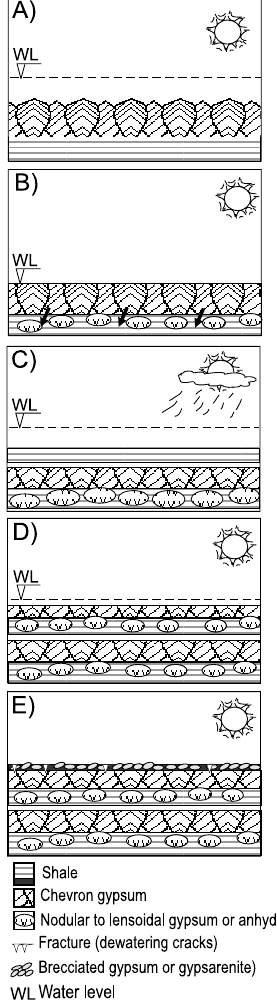
Fig. 10 – A model explaining the formation of the light and dark bundles in the laminated gypsum facies, as well as brecciated gypsum or gypsarenite. A) Brine concentration led to growth of vertically-aligned chevron gypsum in the interface between the sediment and the brine. B) During low water level, sulfate- richdescendingflowsresultedintheoriginofdisplacivegypsum, forming nodular to lensoidal gypsum or anhydrite within the sed- iment. C) Renewed phase of higher water level promoted mud deposition. D) The increase in salt concentration due to evapora- tiongaverisetoarenewedphaseoffibrousgypsumformation. E) Extreme evaporation led to the eventual subaerial exposure of the depositionalsurface, brecciationandreworkingofpreviouslyde- posited evaporites, with the consequent formation of brecciated gypsum or gypsarenite